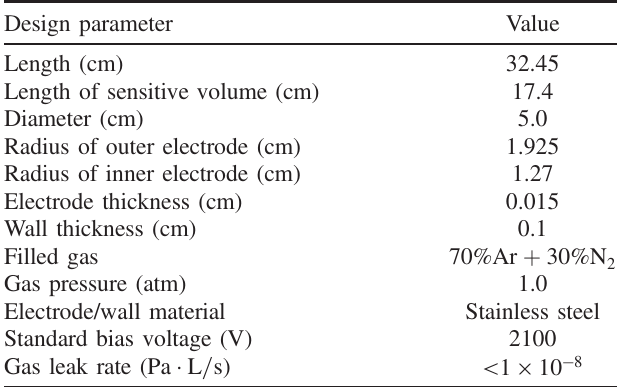
TABLE II. The basic design and operation parameters of the CSNS BLM.